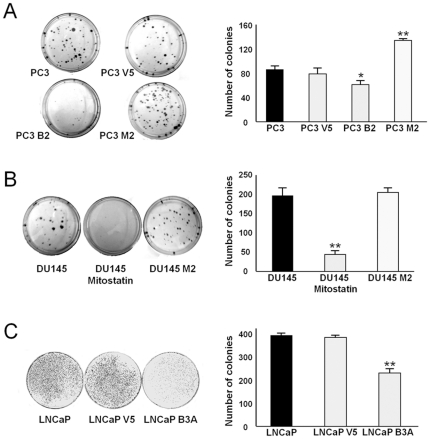
Mitostatin expression affects colony formation of prostate cancer cells.Mitostatin over-expression in prostate cancer derived cell lines [PC3, A; DU145, B; and LNCaP, C] decreased the ability to form colonies after 15 days, while cells with depletion of endogenous Mitostatin protein showed a similar (DU145 M2) or higher (PC3 M2) number of colonies compared to parental cells. Columns, average per dish from triplicate experiments; bars, SEM. * P<0.05; ** P<0.01.